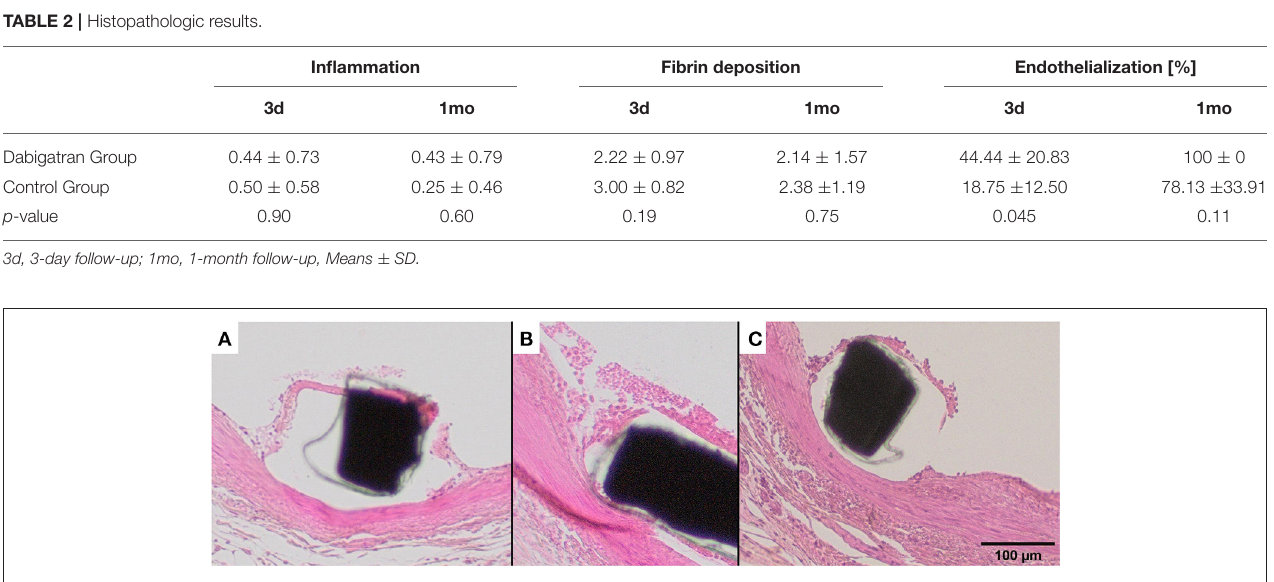
FIGURE 2 | Representative histologic illustration of the tissue coverage over the stent struts at day 3 after intervention with inflammation, fibrin and endothelialization. (A) Tissue coverage over the stent struts with mainly fibrin, (B) with inflammatory cells and (C) with endothelial cells and leucocytes over the stent struts at day 3 after intervention, regardless of the treatment